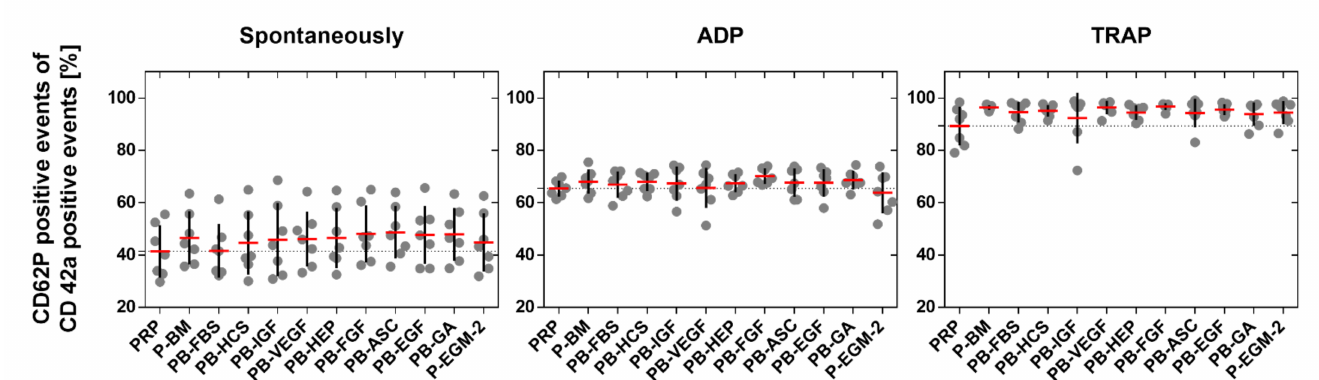
Figure 5. Amount of activated platelets. Platelet-rich plasma (PRP) was mixed with basal medium (BM) or with BM containing one of nine different supplements or with BM containing all nine supplements (see Table 1 for nomenclature) in a ratio of 1:1. PRP served as control. PLT were incubated for 5 min with different supplements (spontaneous activation) or with supplements and a platelet activator (adenosine diphosphate (ADP) or thrombin receptor activating peptide (TRAP)) prior to fixation and immunological staining to detect the surface markers CD42a (platelet marker) and CD62P (platelet activation marker) by flow cytometry. Thin dashed line shows the value for PRP (control). Data represent the arithmetic mean (red) ± standard deviation (black), n = 7.